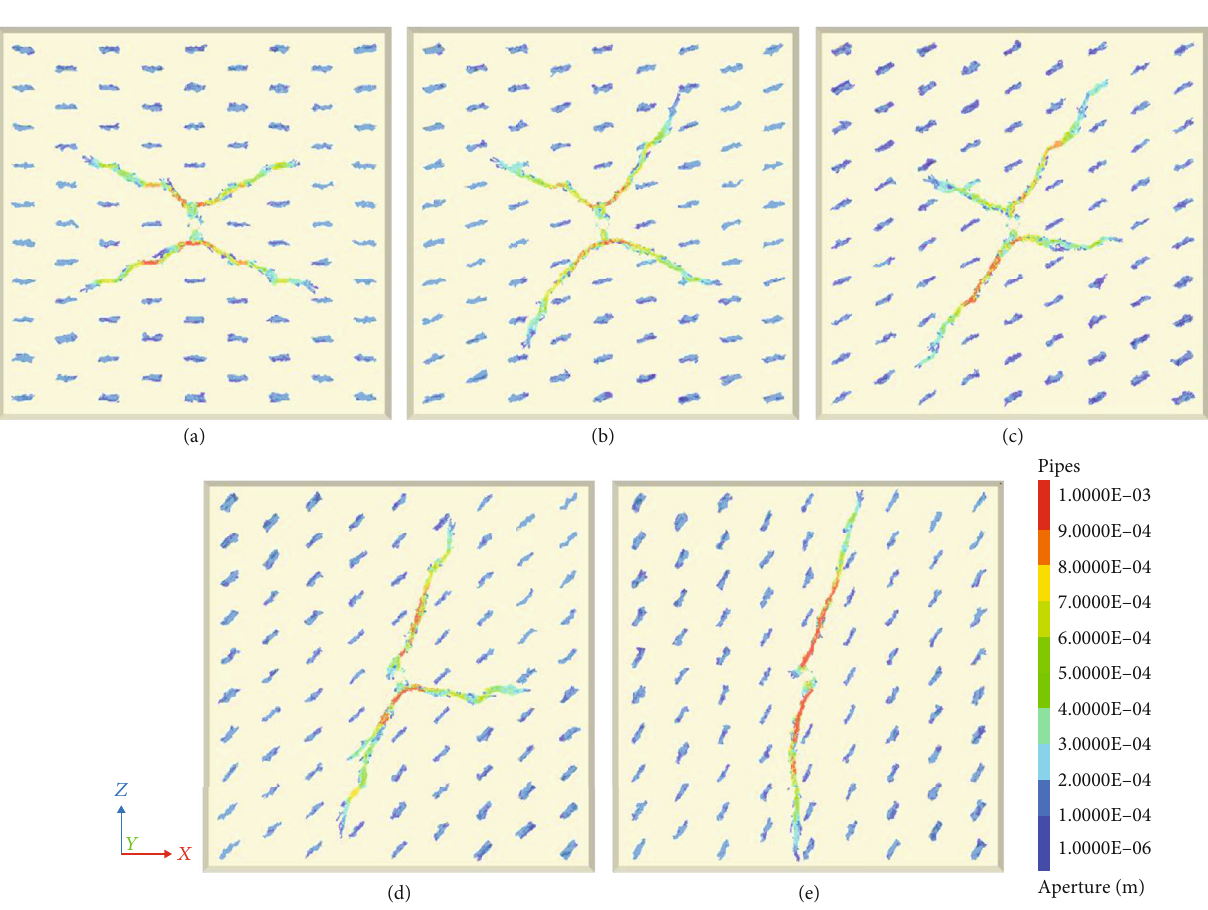
Figure 17: HF propagation in the NFN with di ff erent NF dip angles: (a) 0 ° , (b) 15 ° , (c) 30 ° , (d) 45 ° , and (e) 60 ° .